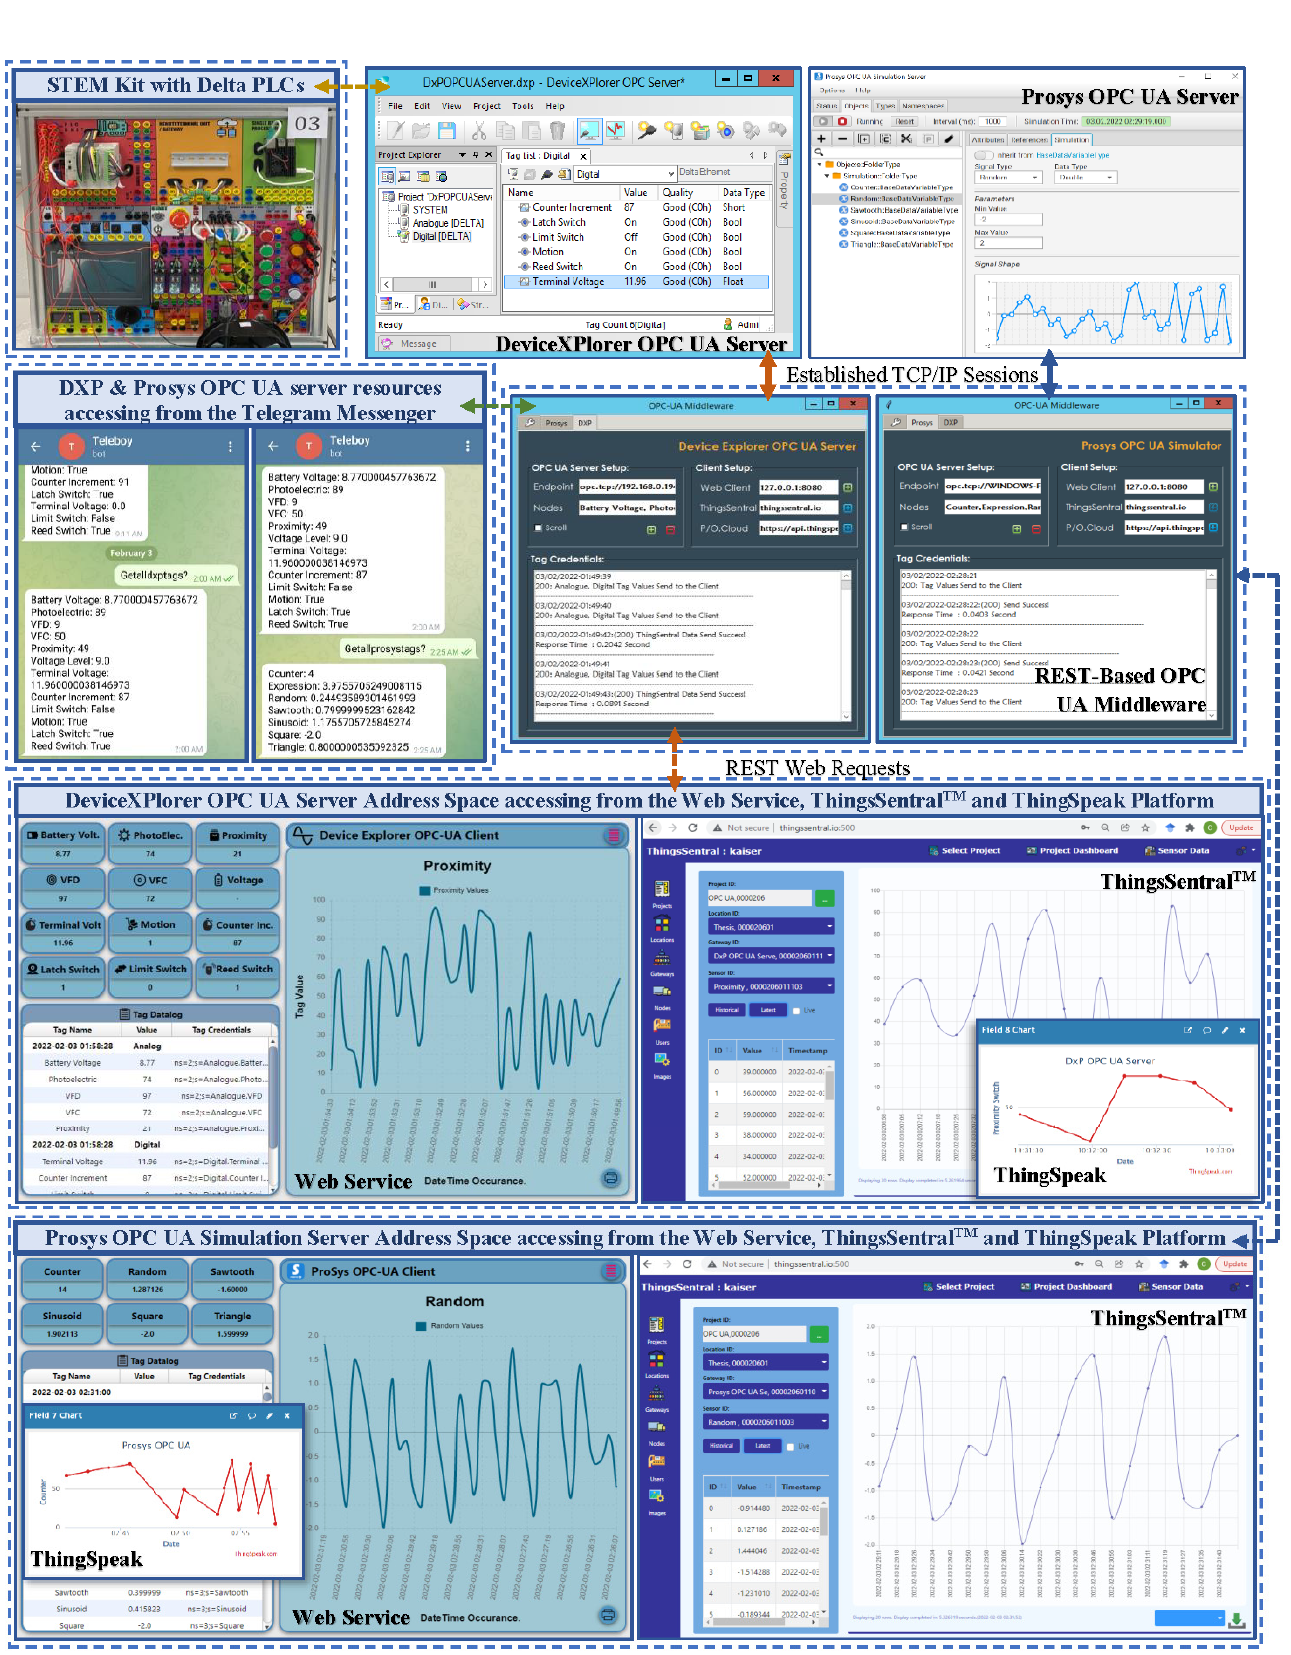
Figure 15. Evaluation setup of the developed system with proprietary and open-source software.